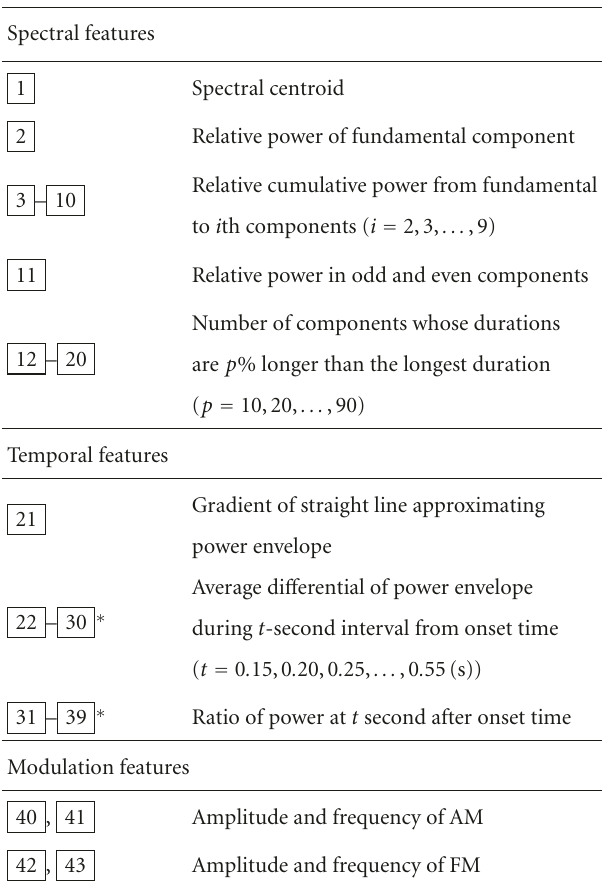
Figure 5: Flow of our instrument identification